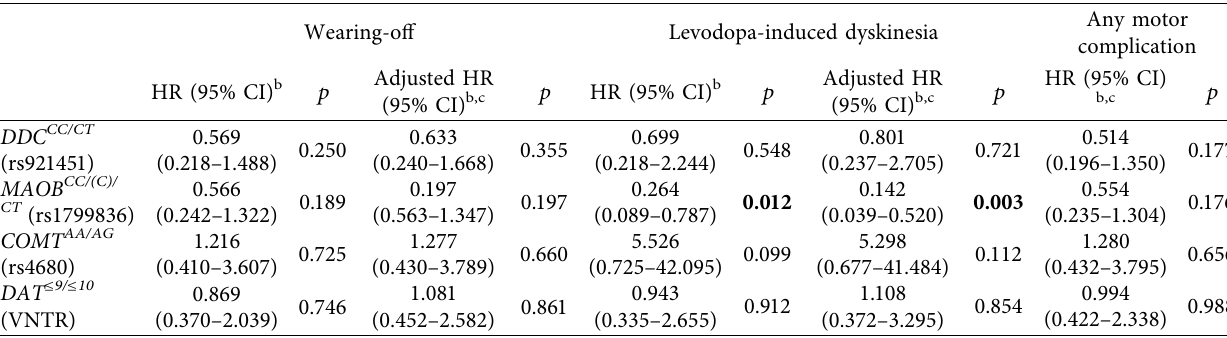
Table 1: Cox proportional hazard ratios estimating the risk for motor complications with respect to genotypes in functional polymorphisms associated with lower enzyme/transporter activity a .